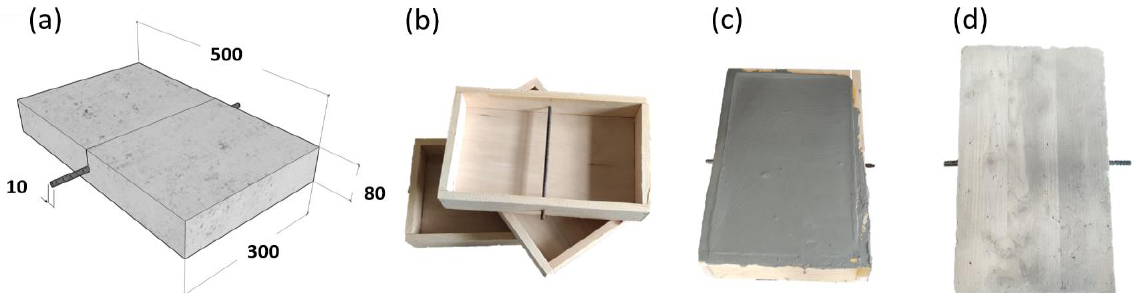
Figure 2. Reinforced concrete laboratory sample; ( a ) project of the realized concrete sample and dimension; ( b ) wooden formwork for the construction of the sample; ( c ) sample construction; ( d ) completed reinforced concrete sample.